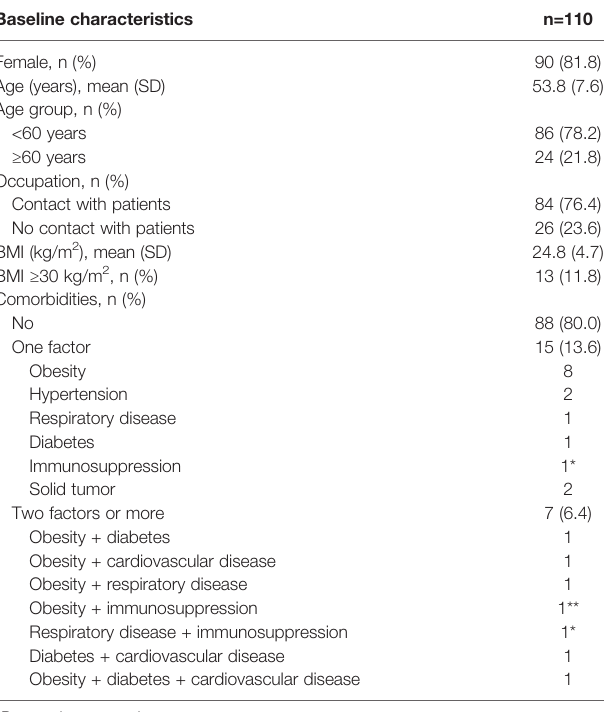
*Betamethasone regimen. **Methotrexate and hydroxychloroquine regimen. BMI, body mass index; SD, standard